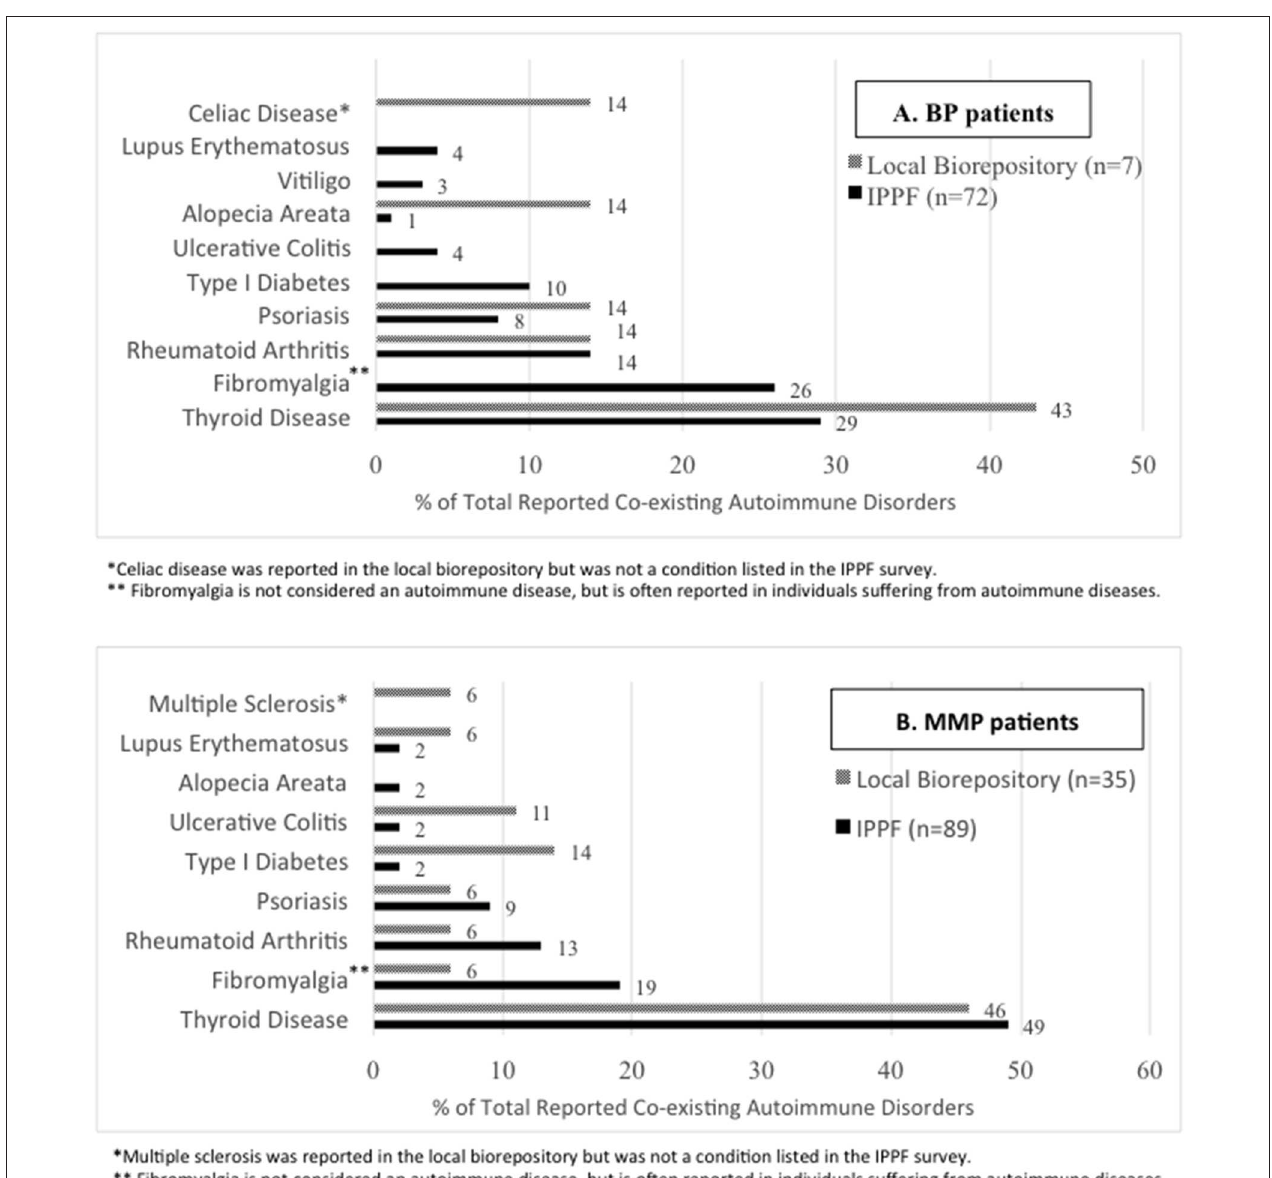
FIGURE 1 | Autoimmune disease comorbidies. The percentages of specific co-existing autoimmune disorders out of all patient-reported autoimmune comorbidities are listed for the IPPF disease registry as well as the local biorepository population among (A) BP and (B) MMP patients.